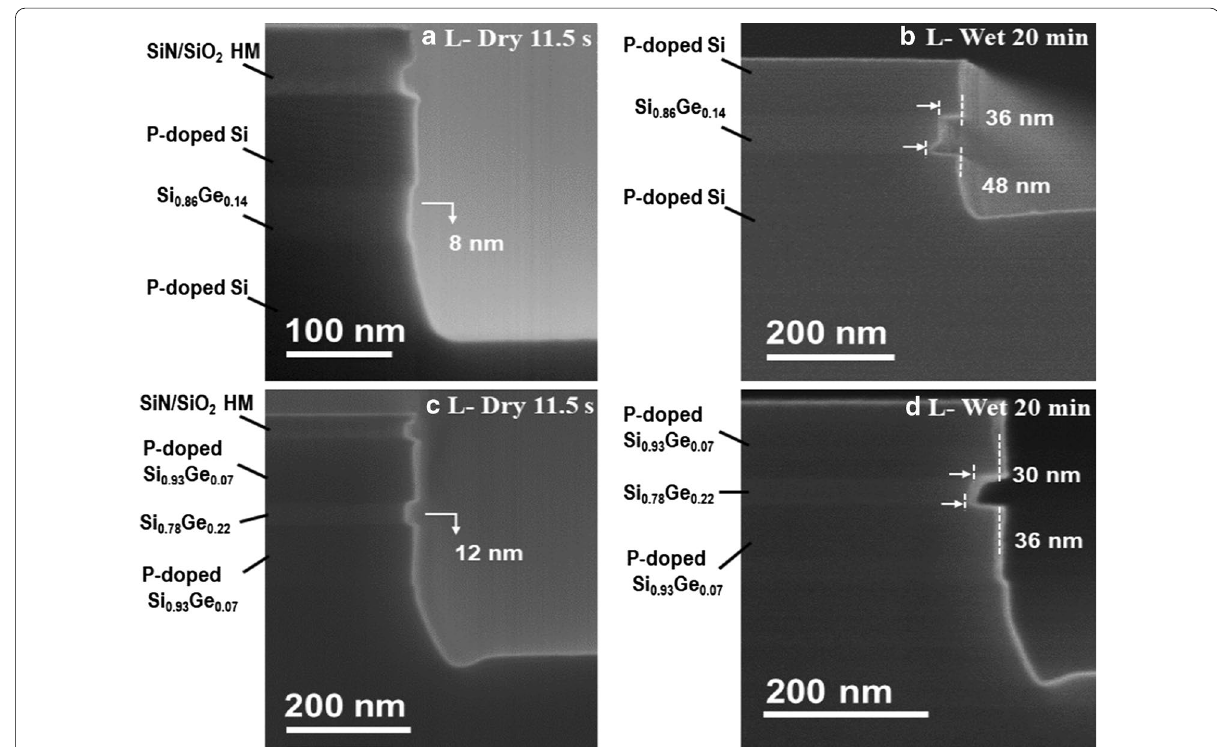
Fig. 6 SEM images of P-doped Si/Si 0.86 Ge 0.14 /P-doped Si in Fig. 2c with a 11.5-s dry etch, b 20-min wet etch, and P-doped Si 0.93 Ge 0.07 /Si 0.78 Ge 0.22 / P-doped Si 0.93 Ge 0.07 MLs with c 11.5-s dry etch, d 20-min wet etch. The dry etch was CF 4 :O 2 :He